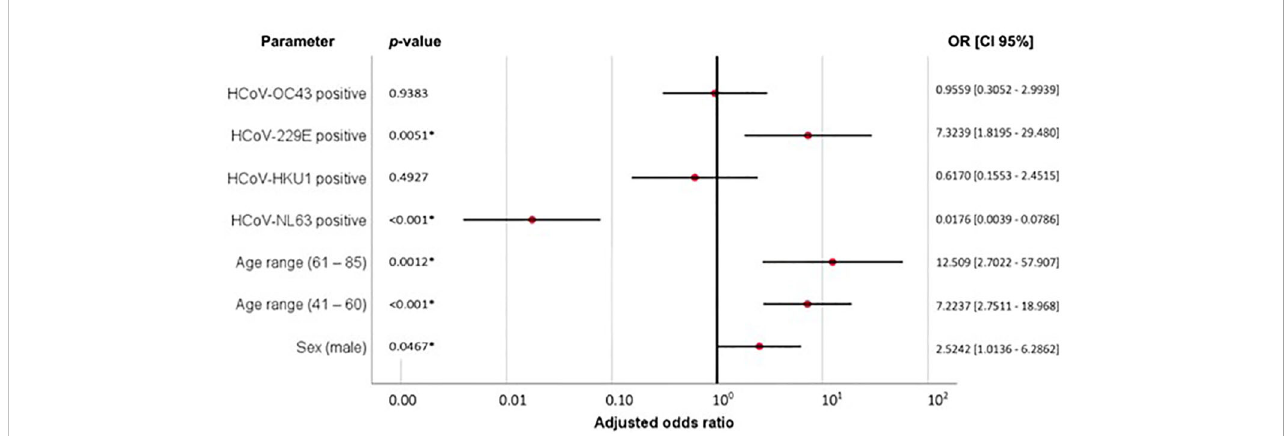
FIGURE 4 Adjusted ORs and 95% con fi dent intervals of Model B (Table 2) describing the association between previous HCoV exposure, age range (61-85), age range (41-60) and male sex, with COVID-19 severity, p < 0.05 is considered signi fi cant and indicated with